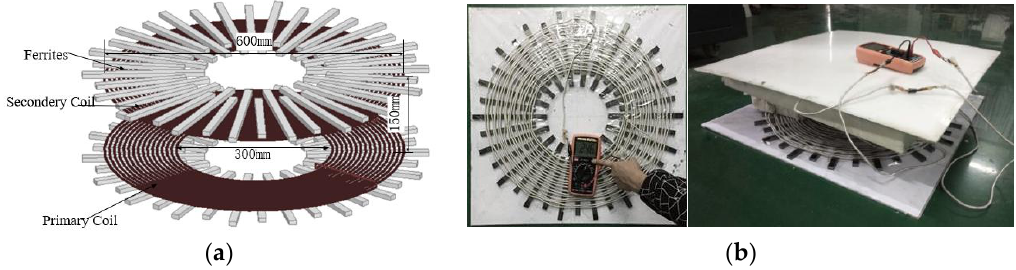
Figure 3. The coupling coils: ( a ) 3D model of coupling coils; ( b ) parameter measurement of coil s. Table 2. Parameters of coils and ferrites.